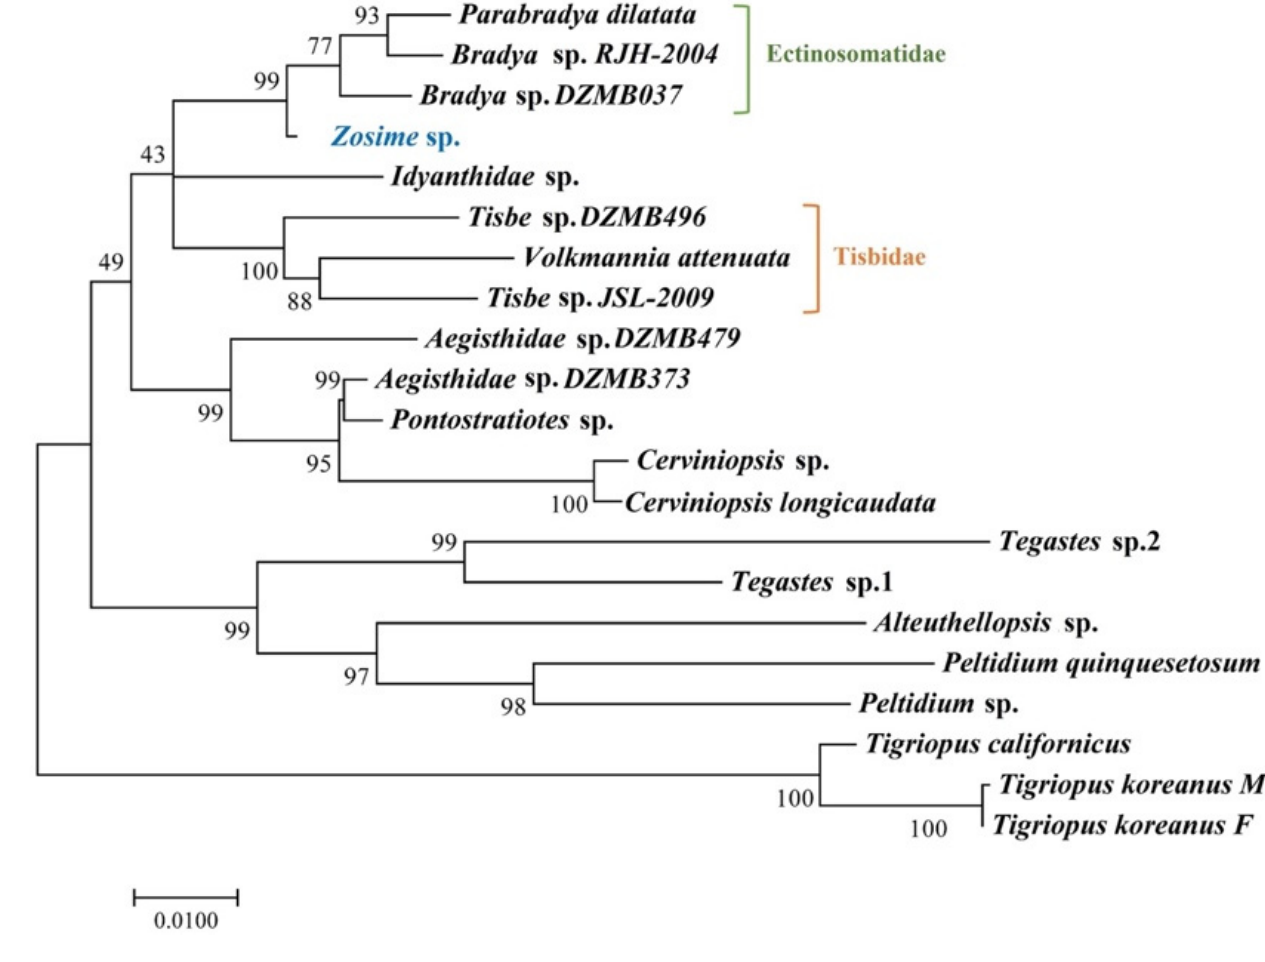
Figure 13. Maximum likelihood phylogenetic tree including Zosimeidae and other families based on 18S rRNA sequences.